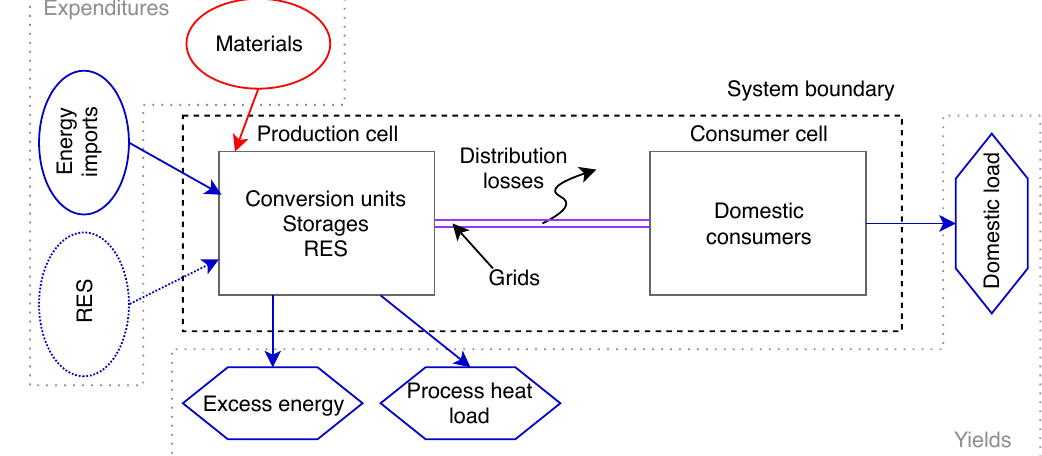
Figure 4. Two cell model with the exergy expenditure and yields. Conversion units, storages, renewable energy sources (RES) and the process heat load are located in the production cell. All domestic consumers are located in the production cell. (Source: own